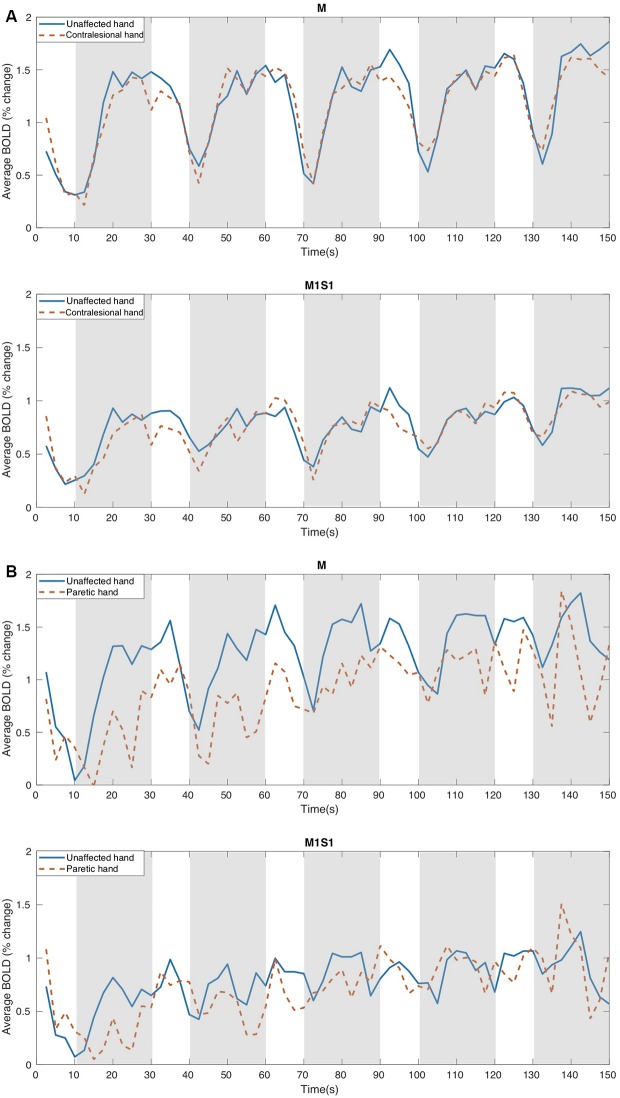
The Mean % Bold variation course for: (A) NCP (no cerebral palsy) and (B) CP patients using the two types of ROIs, M, and M1S1, in response to the motor task performed with the unaffected and the contralesional (paretic in the case of CP) hand. M indicates the ROIs obtained from the controls activation areas and M1S1 represent the atlas-based ROIs. The motor task intervals are illustrated in gray.